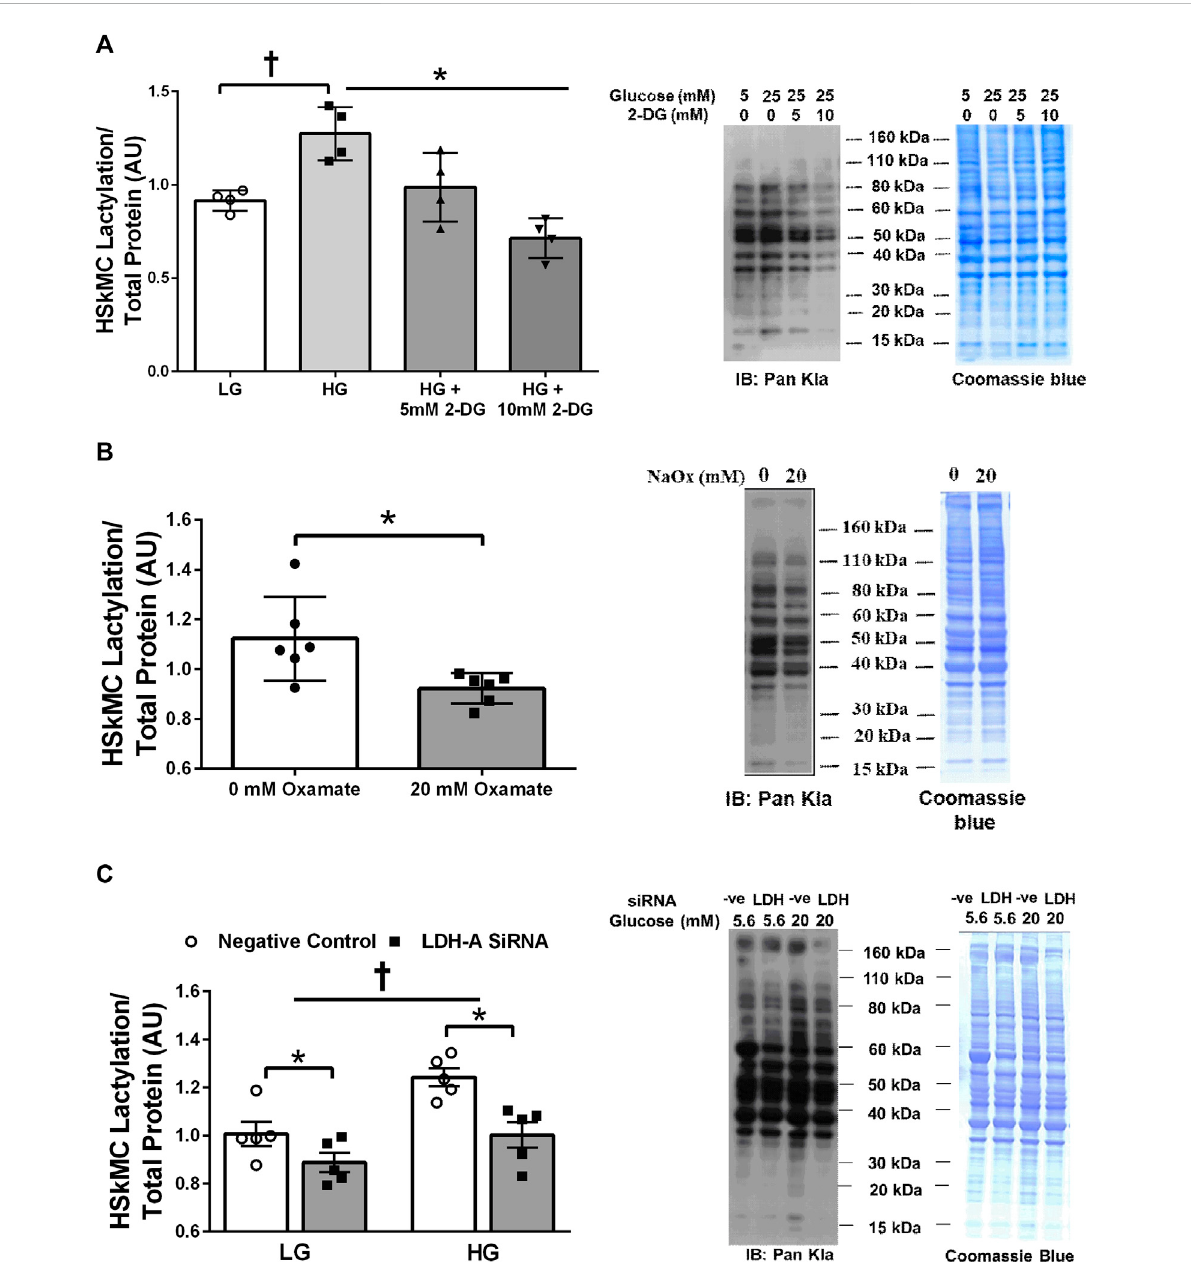
Human Primary Skeletal Muscle Cell Lactylation in Response to Glycolytic Intervention. Quanti fi cation of primary human skeletal muscle cell (HSkMC) lactylation in response to 24 h low glucose (LG, 5.6 mmol/L) and high glucose (HG, 20 mmol/L) treatment and in response to 24 h 2-DG treatment (n = 3) and representative blot for pan-kla (A) . Quanti fi cation of HSkMC lactylation in response to 24 h sodium oxamate treatment (n = 3) and representative blot for pan-kla (B) . Quanti fi cation of HSkMC lactylation in response to negative control (Silencer Select) and LDH siRNA underlowglucose(LG,5.6 mmol/L)andhighglucose(HG,20 mmol/L) treatment(n=8)andrepresentativeblotforpan-kla (C) .Myotubelactylation levelswerenormalizedtoCoomassieBlue. Data isexpressedas mean±SEM.* p < 0.05maineffectfor inhibitory treatment; † p < 0.05lowglucosevs high glucose. Sample size (n) represents biological replicates from HSkMC derived from different